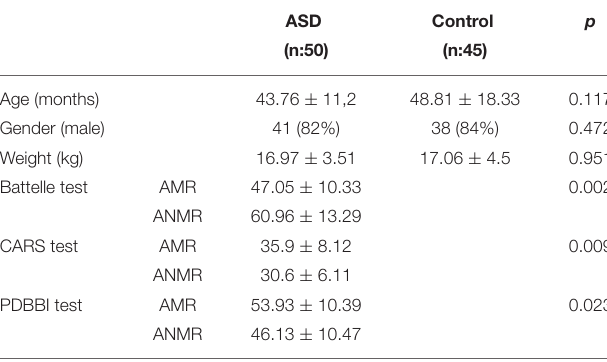
TABLE 2 | Demographic and anthropometric data in children with autism spectrum disorders compared to controls.